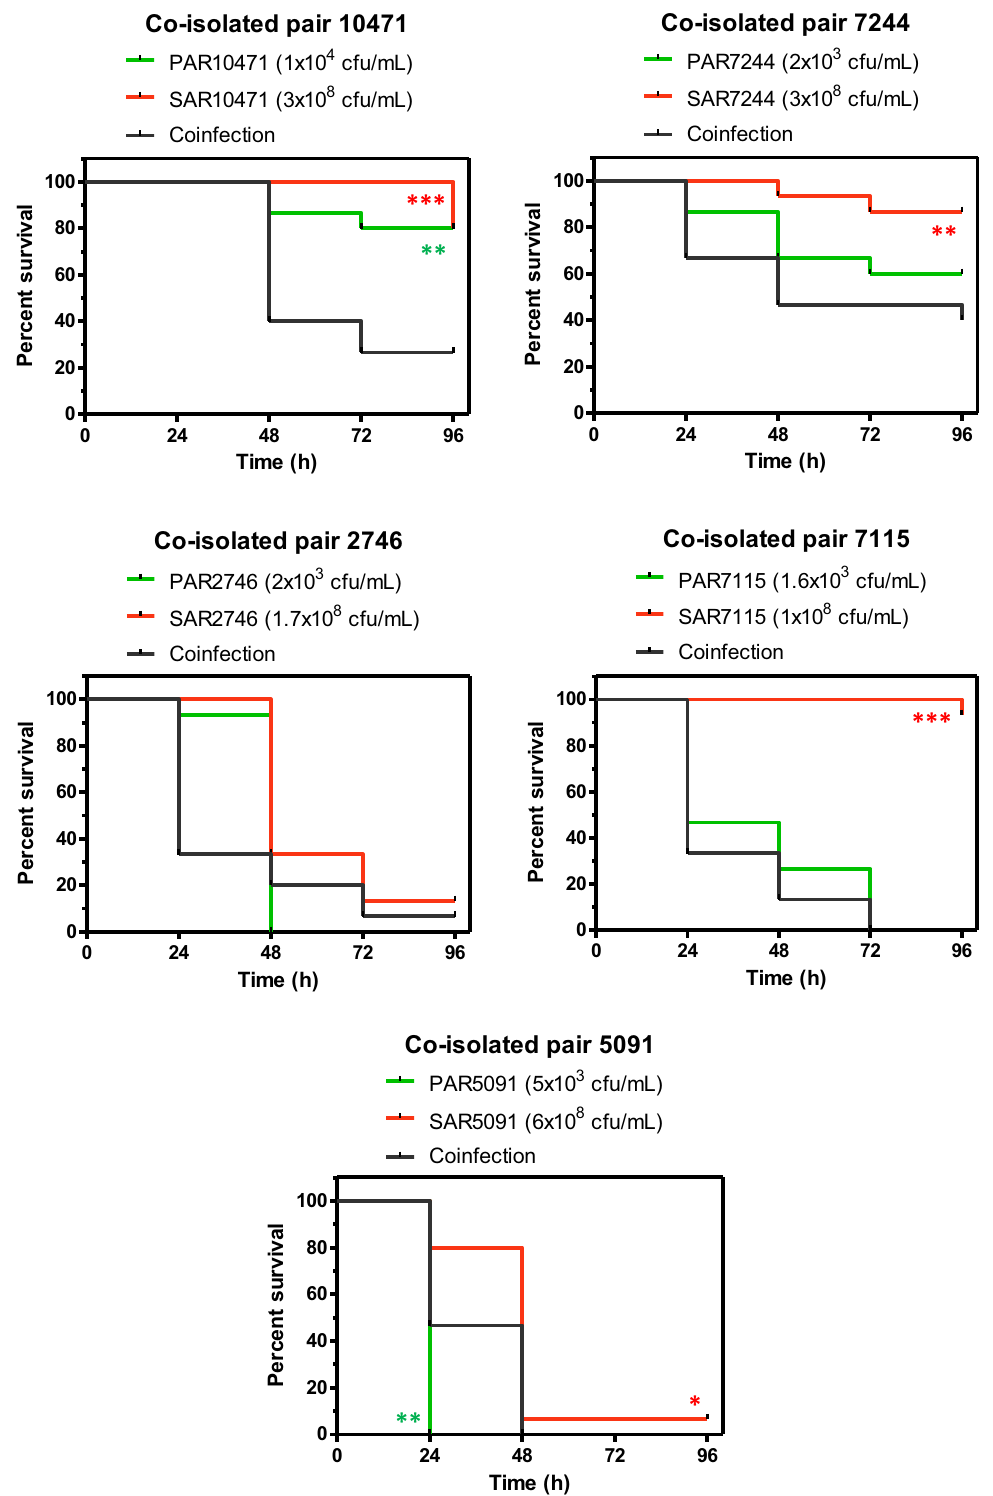
Figure 6. Co-infection in vivo shows an additive effect for the co-isolated pair with ID 10471. Survival of Galleria mellonella larvae over 96 h following infection with single species microorganisms ( P. aeruginosa or S. aureus ), or dual-species microorganisms (co-infection). Each panel represents a pair of co-isolated strains where each strain was used at the indicated infective dose prepared in PBS. Asterisks indicate significant differences relative to co-infected larvae, as assessed by the log-rank test. Only significant differences are